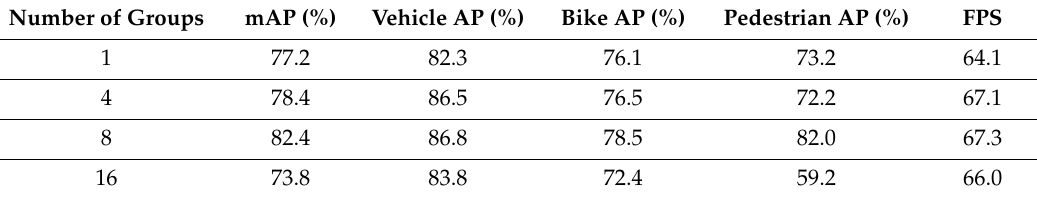
Table 9. The mAP of di ff erent groups of pass through.